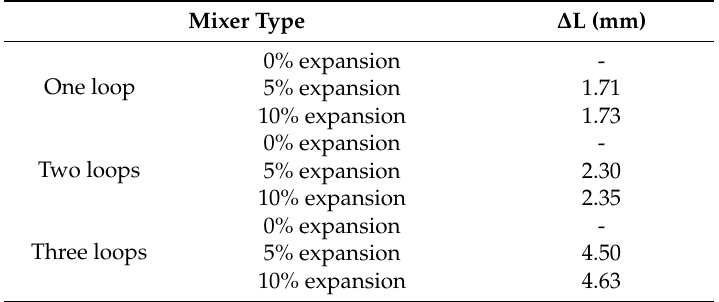
Table 6. Effect of adding expansion parts on the increase of mixing length in comparison to the mixers without expansion